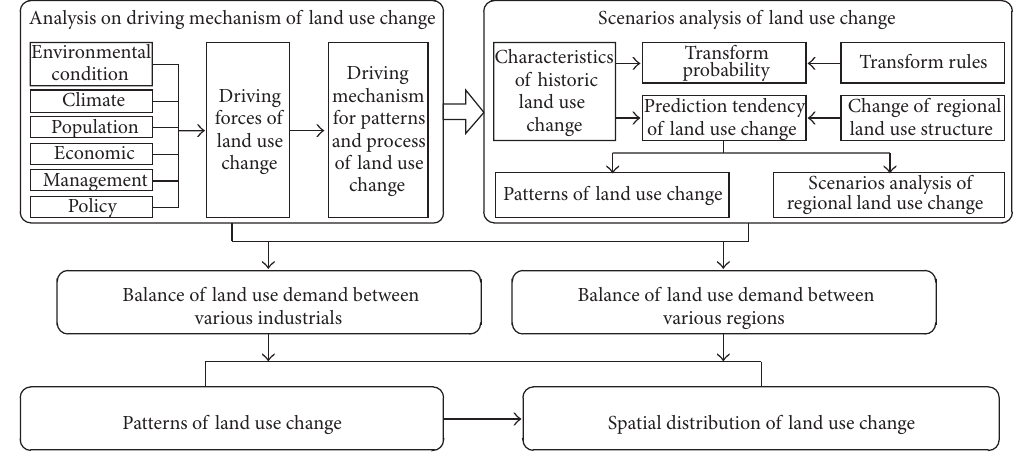
Figure 2: Framework of DLS model.